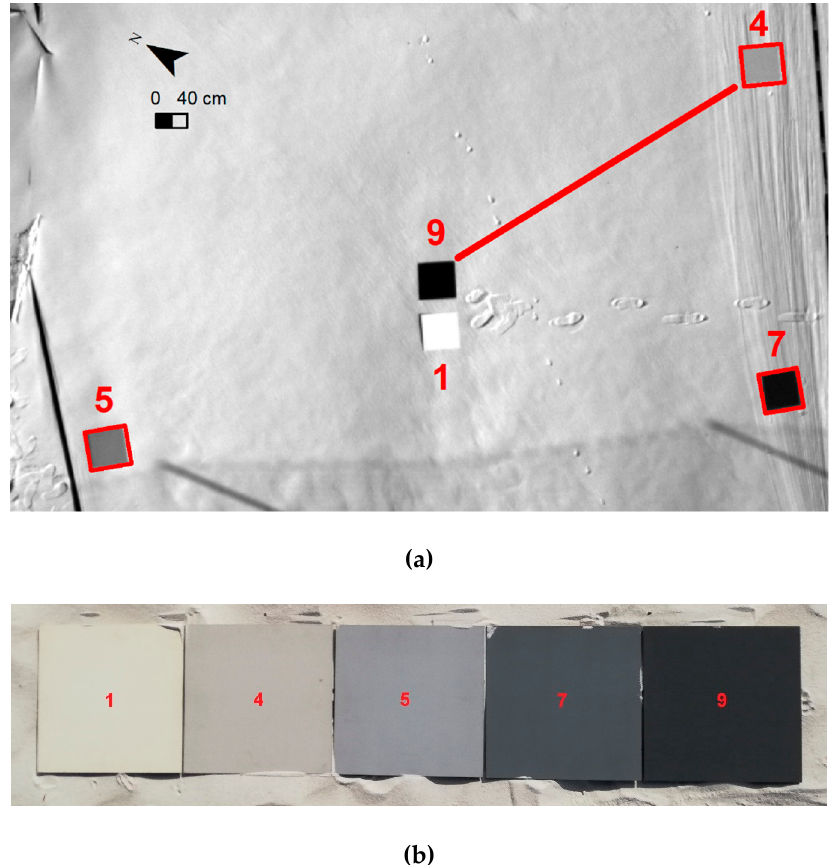
Figure 5. ( a ) The design of the field experiment. The single image in sensor geometry with the ground sampling distance (GSD) of 0.75 cm was used for the analysis . Figure shows the distribution of calibrating (1, 9) and validation (4, 5, 7) targets. Red line marks the profile to test the hypothesis that the variation of pixels along profile extracted from original non-corrected image is greater than the variation of pixels extracted from correction image. Red squares mark the validation targets; ( b ) The detailed view on targets.